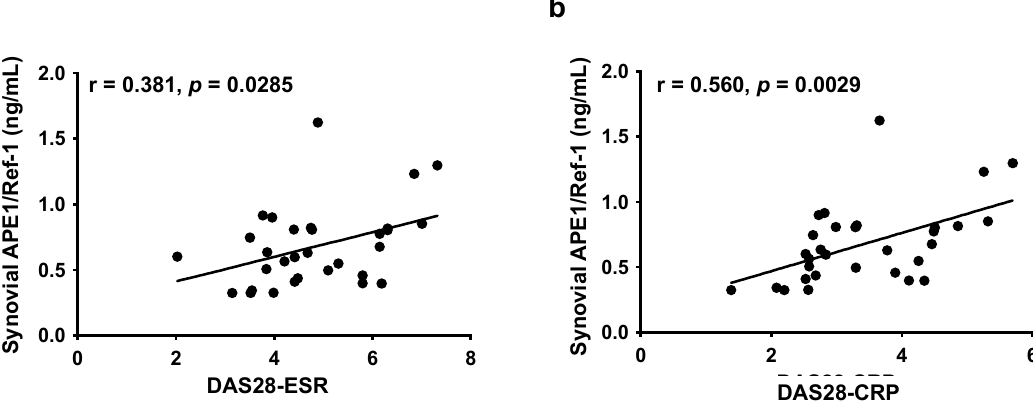
Figure 3. Correlation between synovial APE1/Ref-1 levels and rheumatoid arthritis (RA) disease activity; ( a , b ) 28-joint disease activity score (DAS 28), using ESR and CRP (DAS28-ESR/DAS28-CRP). Statistical significance was determined by Pearson’s correlation analysis.